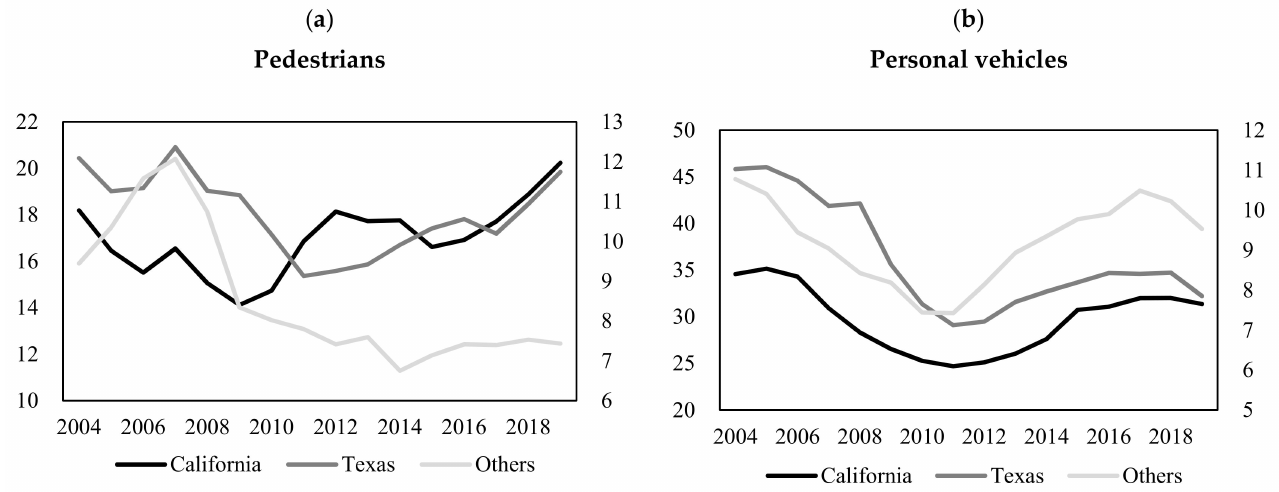
Figure 2. Northbound PoE’s annual pedestrian and personal vehicle crossings by regions, from 2004 to 2019 (million). Note: The annual data are from 2004 to 2019 and are in millions. In Figures ( a ) and ( b ), the crossings for other are on the right vertical axis. Source: Own estimations using data from the Bureau of Transportation